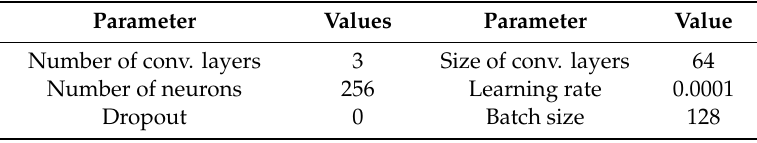
Table A1. Details of the common architecture and hyper-parameters.